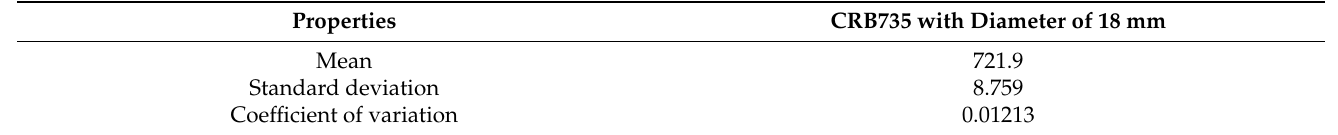
Table 3. The test data were obtained from standard compression tests on nine bars. Table 3. Compressive property parameters of CRB735 with diameter of 18 mm